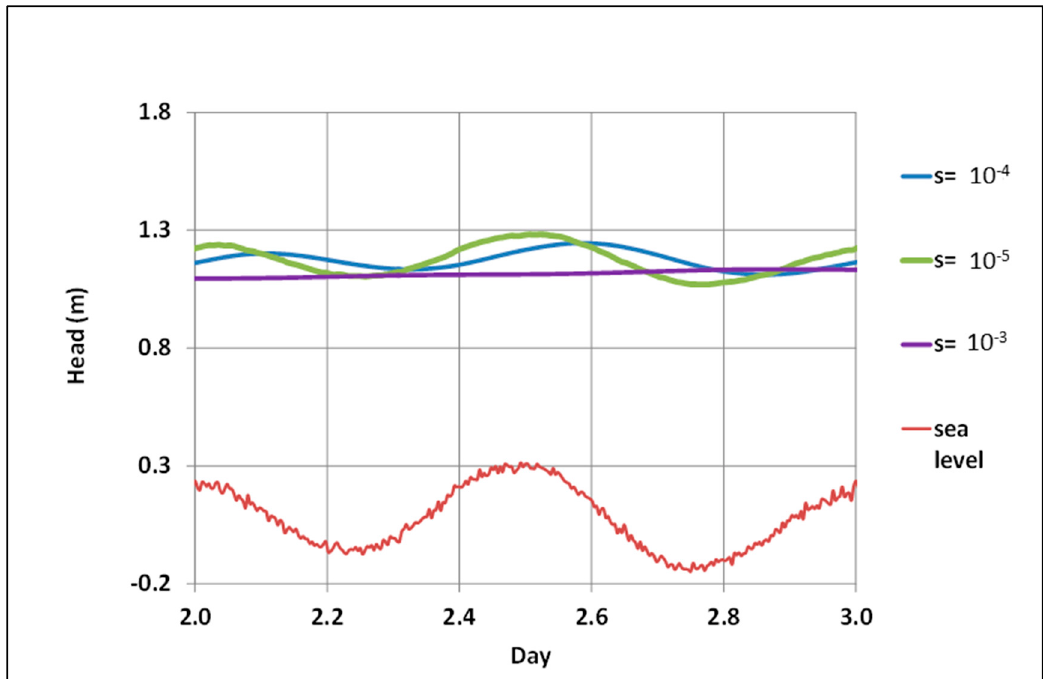
Figure 13. Transient heads at observation point 2 in the northern site (indicated in Figure 10, representing borehole 73) for various values of storativity/specific staorge of the confined unit B. Using high storativity, the aquifer tidal signal lags significantly after the sea, which is in disagreement with our observations.